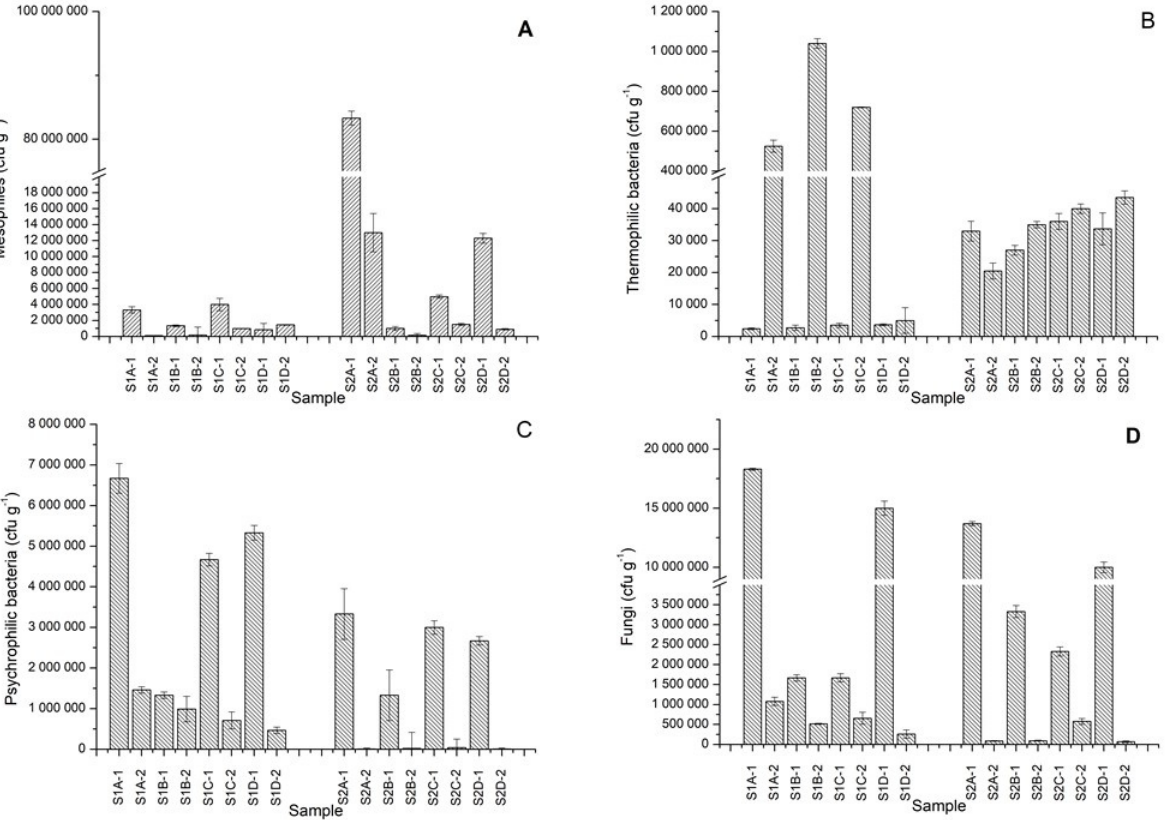
Figure 7. The community of mesophiles (A), thermophiles (B), psychrophiles (C), and fungi (D) in the studied soils. S1: soil from the limestone open-cast mining remediated with embankment; S2: soil from the lignite open-cast mining remediated with sewage sludge; subsequent letters A–D mean different remediated areas located at the same mine; subsequent numbers mean different sampling periods; 1: spring 2021, 2: spring 2022. Mean values ± SD, n = 3.